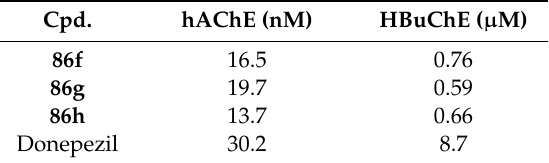
Table 13. IC 50 values of compounds 86f–h on human AChE (hAChE) and BuChE (hBuChE) [60]. Cpd.